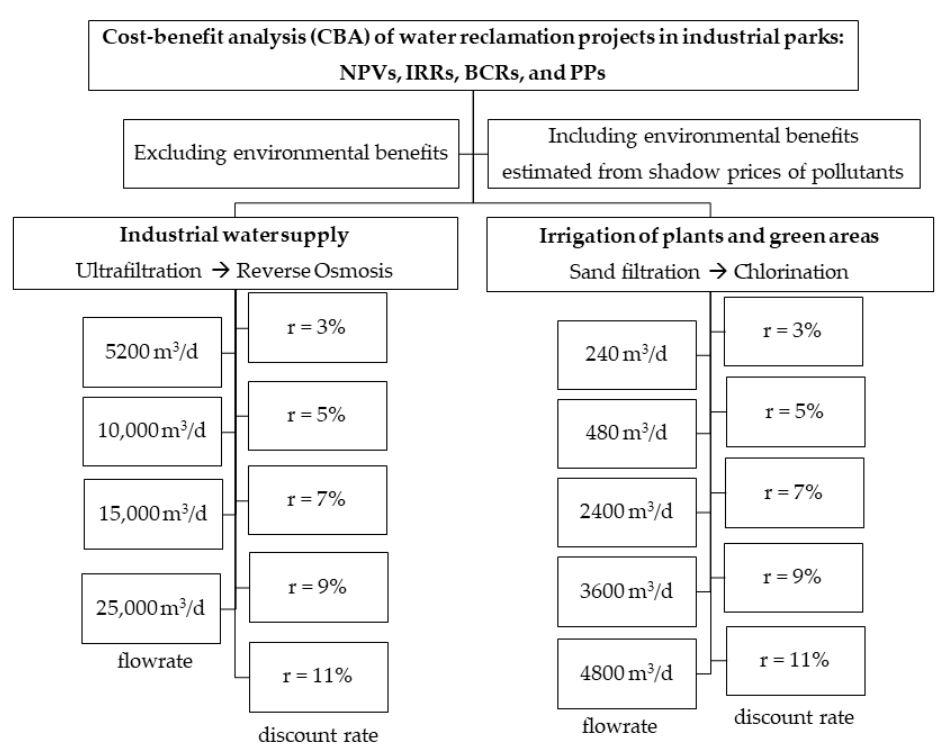
Figure 2. Methodology flowchart of the CBA of water reclamation projects in industrial parks.